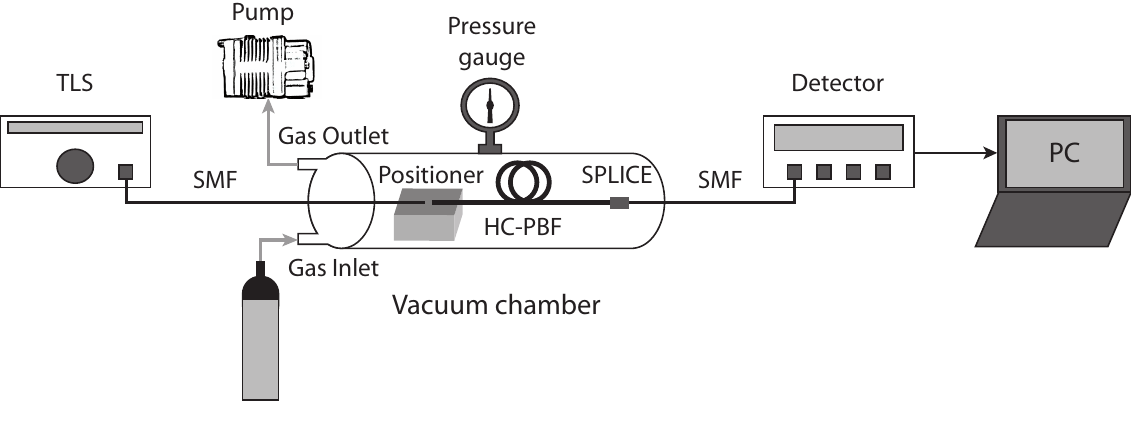
Figure 4. Experimental setup for methane detection experiments using HC-PBF as gas